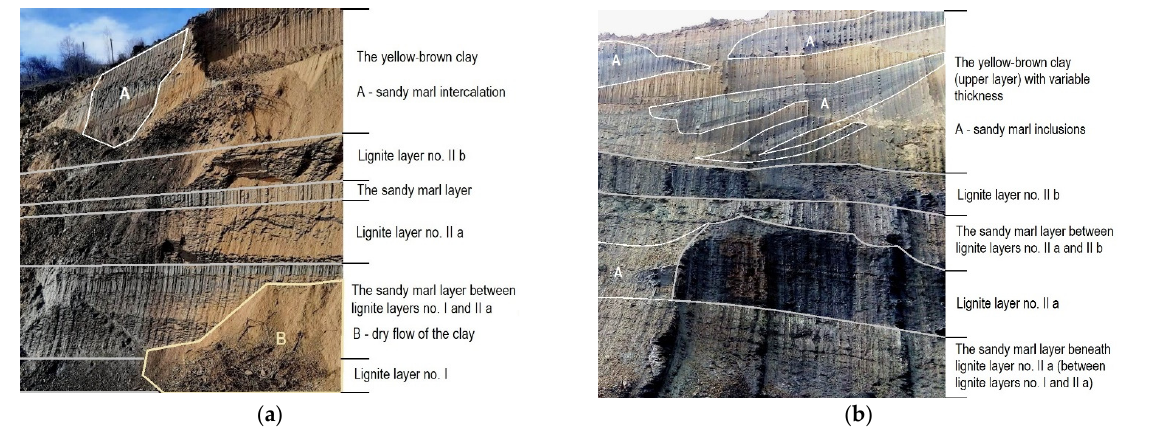
Figure 4. ( a ) The alternation of rock layers; ( b ) the discontinuity of rocks with variable thicknesses (the pictures were taken at different moments in time, in different weather conditions and from different distances and angles relative to the working front).